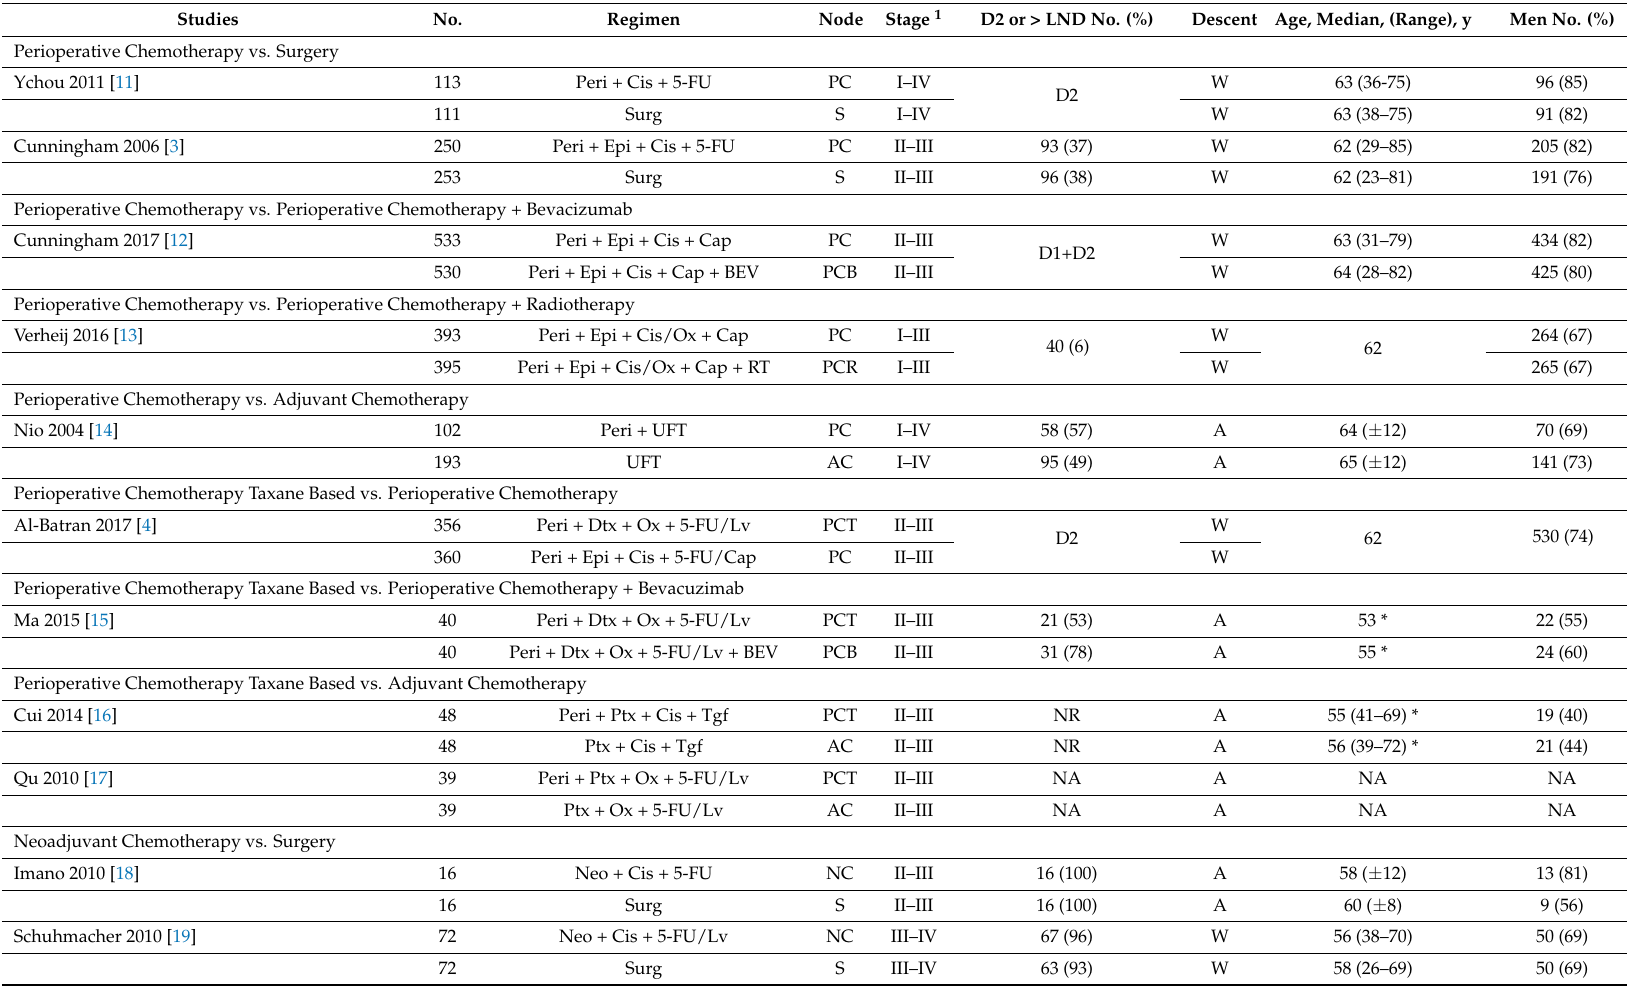
Table 1. Baseline characteristics of studies included in the treatment-strategy network meta-analysis (NMA-1). Studies